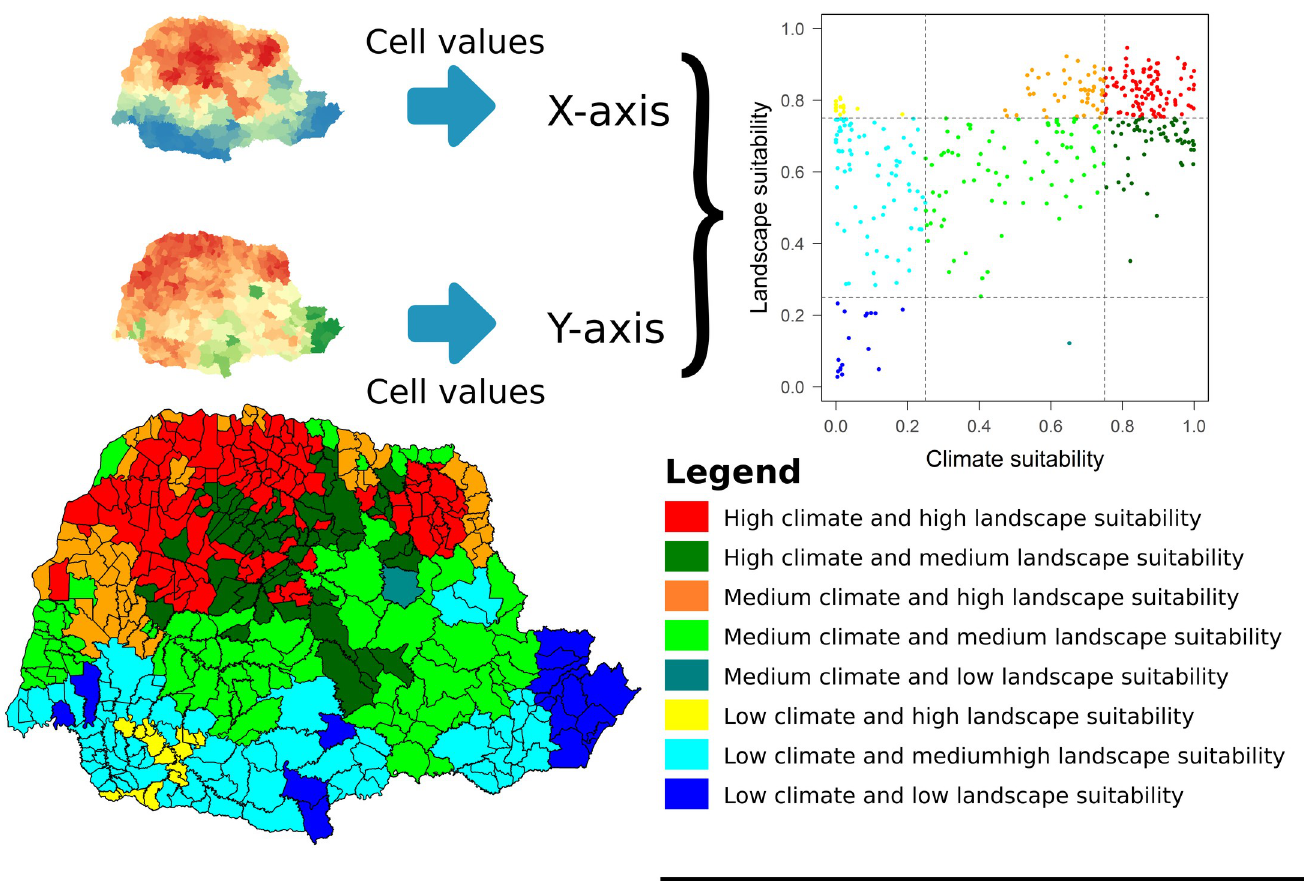
Fig 5. Distribution of triatomines according to climatic and landscape conditions for municipalities within Parana´ state, Brazil. Software: R Source: IBGE (2015). Instituto Brasileiro de Geografia e Estatı´stica. Continuous cartographic bases (1:250.000). Avaliable from: ftp://geoftp.ibge.gov.br/cartas_e_mapas/ basescartograficas_continuas/bc250/versao2017/. Author: Maurı´cio Humberto Vancine.